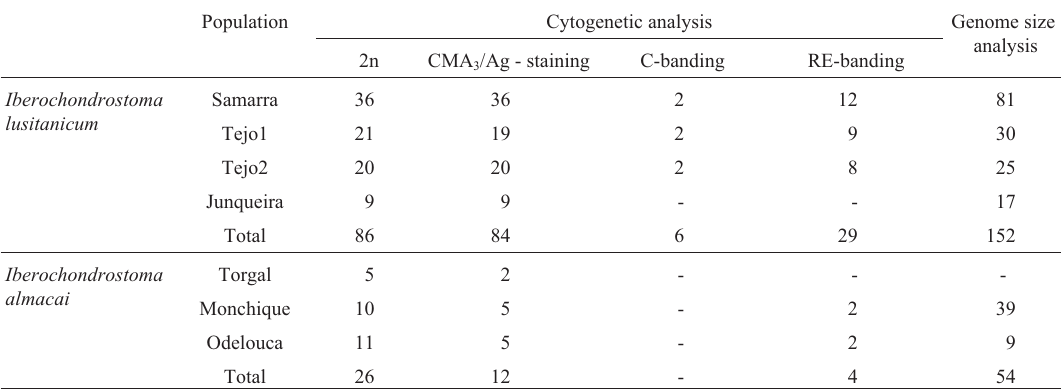
Table 1 - Number of specimens from each population subjected to each kind of